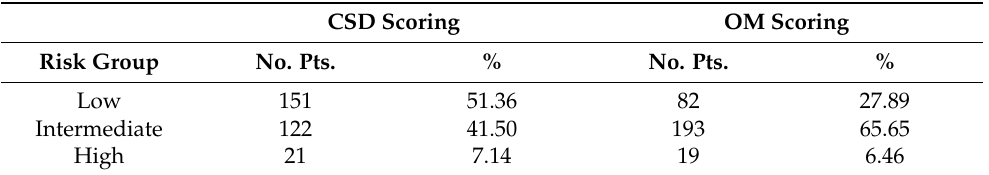
Table 8. Risk groups for cancer-specific death and all-cause mortality after surgical treatment of clear cell renal cell